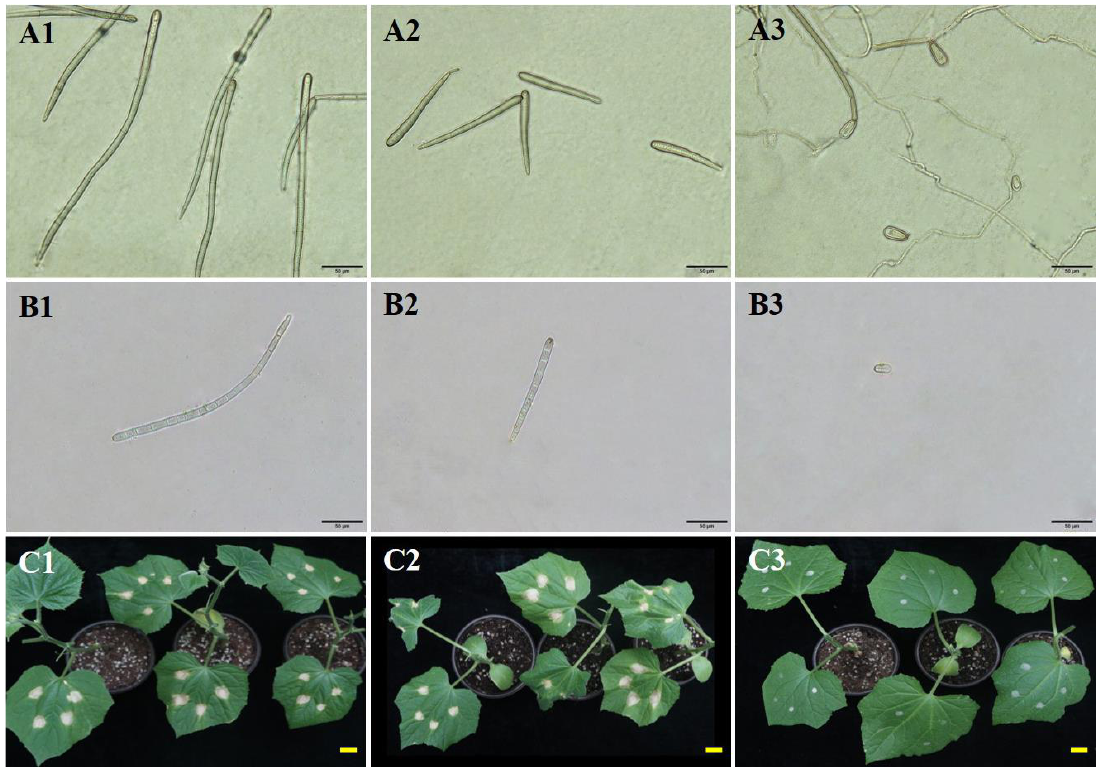
Figure 5. Influence of spore size on the virulence of Corynespora cassiicola in cucumber. ( A1 – A3 ) Morphological characteristics of C . cassiicola produced on the cucumber leaves incubated under 100%, 85%, and 75% RH at 28 °C for 12 h; ( B1 – B3 ) Spore suspensions of C . cassiicola collected from the cucumber leaves incubated under 100%, 85%, and 75% RH at 28 °C for 12 h; ( C1 – C3 ) At 7 days after incubation (DAI), symptoms of cucumber seedlings caused by spore suspensions collected from the cucumber leaves incubated under 100%, 85%, and 75% RH (Scale bars, 10 mm).